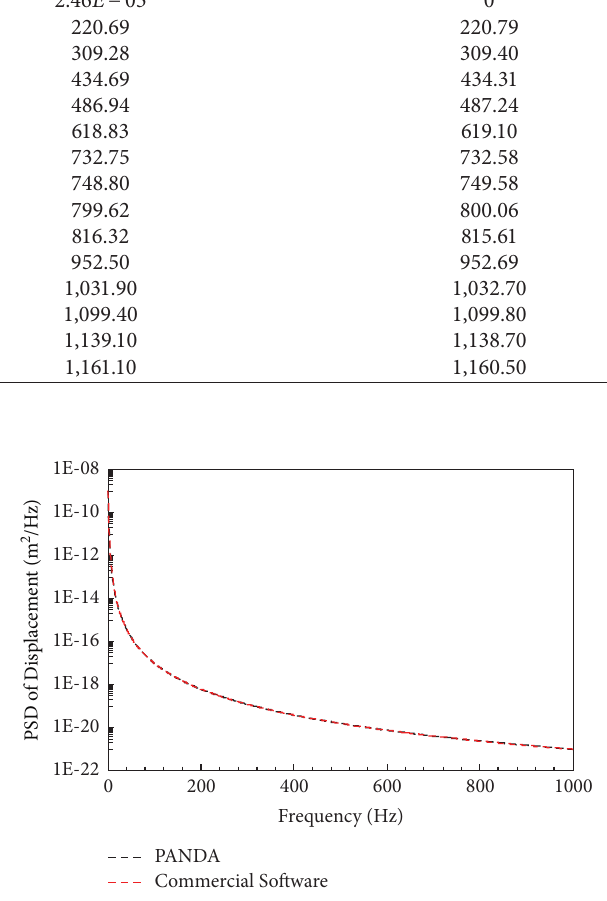
Figure 8: The PSD curves for rigid-body